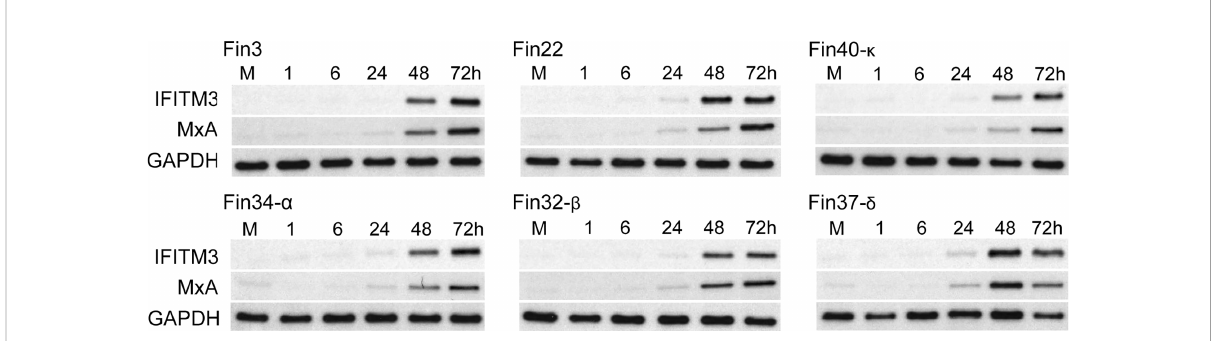
FIGURE 5 Kinetics of expression of antiviral ISGs in Calu-3 cells infected with different SARS-CoV-2 variants. Six different virus variants were used at MOI of 1 TCID 50 /cell to infect Calu-3 cells and during the 3-day infection cellular protein samples were collected. Representative immunoblots were probed with antibodies against interferon induced transmembrane protein 3 (IFITM3) (carried out once) and human Myxovirus resistance protein A (MxA) (carried out twice). GAPDH was used as a loading